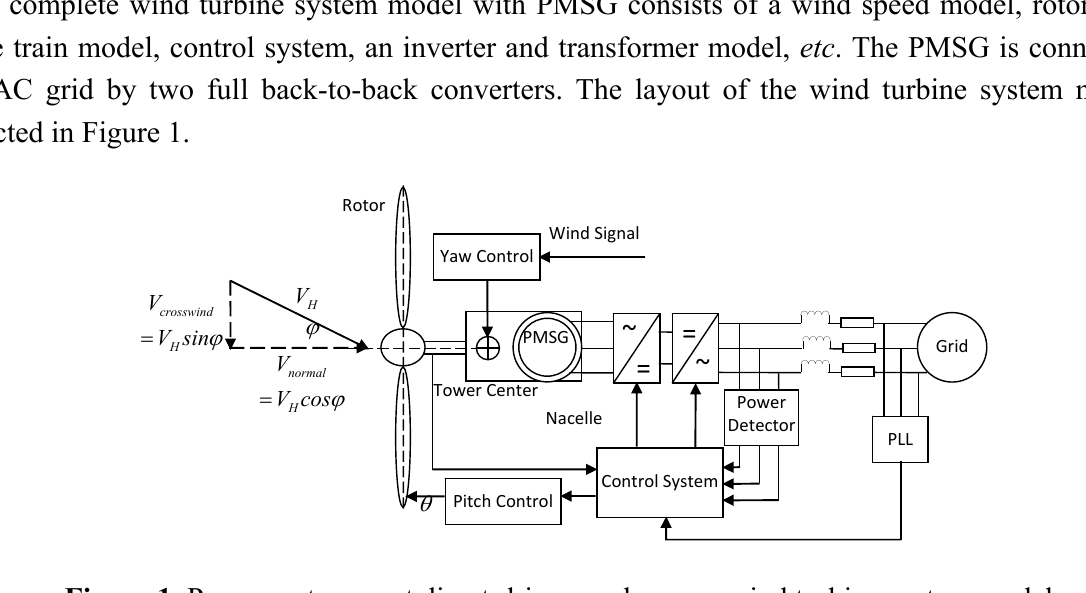
Figure 1. Permanent-magnet direct-drive synchronous wind turbine system